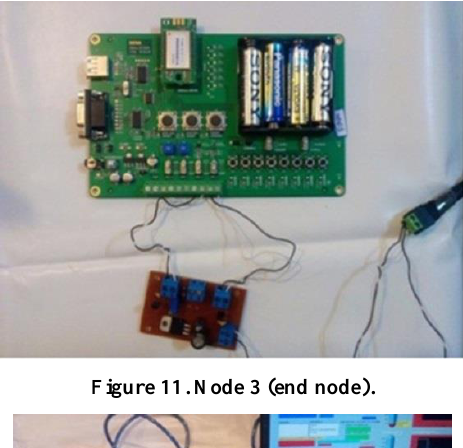
Figure 11. Node 3 (end node).